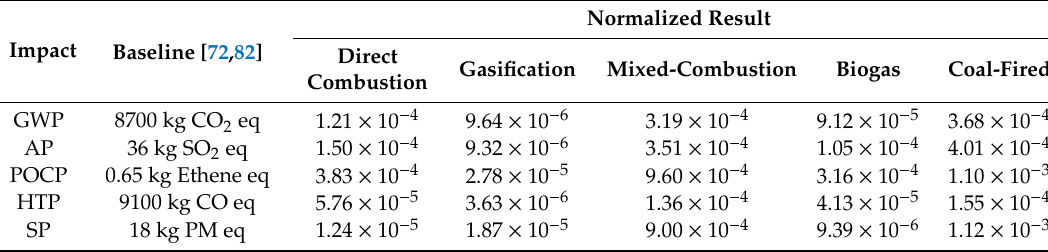
Table 4. Normalized reference value and normalized